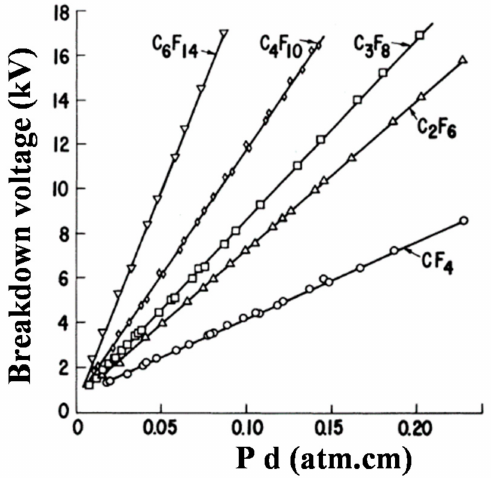
Figure 1. Paschen curves for some fluoroalkanes